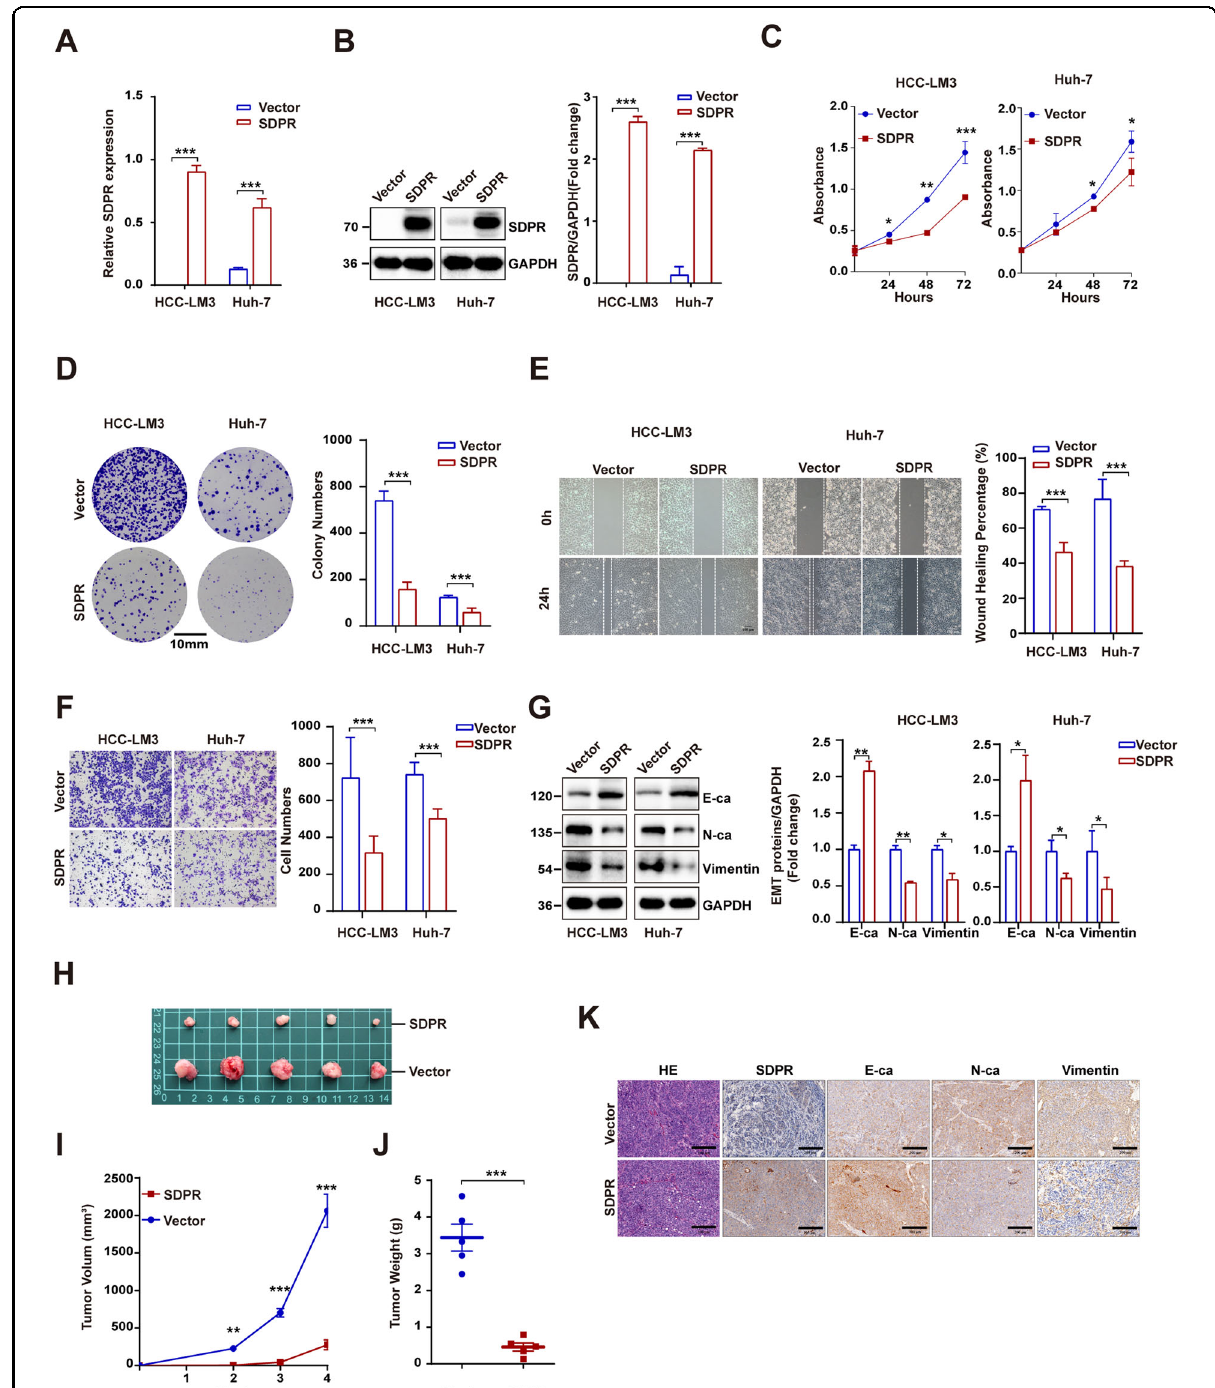
Fig. 2 SDPR overexpression inhibited HCC cells proliferation, migration, and invasion in vitro and repressed tumor growth in vivo. A , B Identi fi cation of cell lines stably integrating SDPR by qRT-PCR and western blotting in HCCLM3 and Huh-7 cell lines. C , D Cell counting kit-8 analyses and colony formation revealed that SDPR restrained hepatoma cells growth in SDPR overexpressing HCCLM3 and Huh-7 cell lines. E , F Overexpression of SDPR in HCCLM3 and Huh-7 cell lines suppressed cell migration and invasion and assessed by wound-healing and transwell analyses. G The EMT proteins level of E-cadherin (E-Ca), N-cadherin (N-Ca), and vimentin in HCCLM3 and Huh-7 cell lines after SDPR overexpressed. H Images of tumors obtained from nude mice were implanted with up-regulated SDPR expression HCCLM3 cells ( n = 5) or control cells ( n = 5). I , J Tumor growth curves and tumor weights of SDPR group and control. K Images that indicate the hematoxylin and eosin (H&E) and IHC staining features of E-cadherin, N-cadherin, and vimentin in tumor xenografts of nude mice in SDPR group and control group. * p < 0.05; ** p < 0.01; *** p <